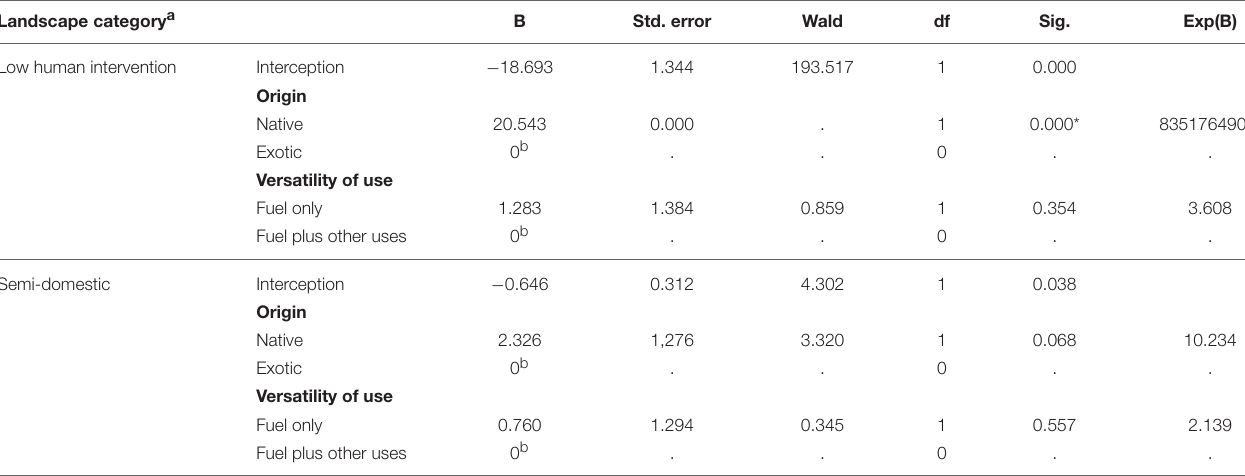
TABLE 3 | Parameters estimated from the multinomial regression. Landscape category a B Std. error Low human